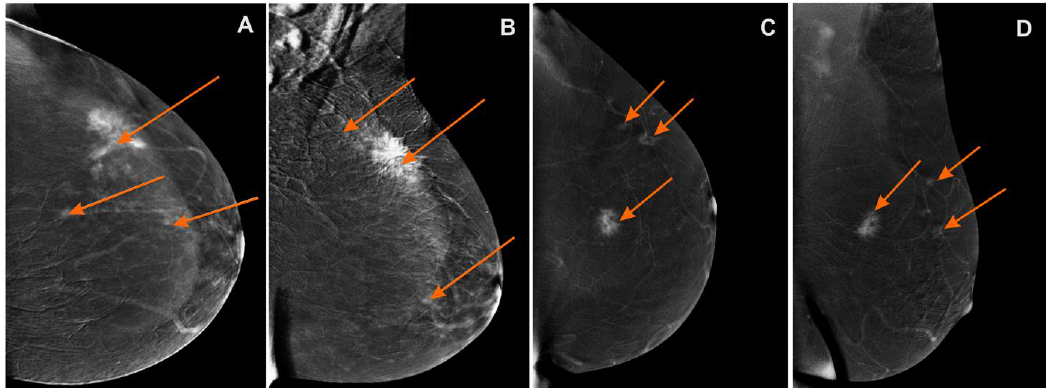
Figure 3. Contrast-enhanced spectral mammography (CESM)subtraction images: ( A ) craniocaudal ( CC ) and ( B ) mediola- teral oblique (MLO) views — irregular mass with heterogeneous enhancement and long spiculated mass BI-RADS 6. Nu- merous enhanced small foci are noted in left breast BI-RADS 4 (orange arrows); ( C ) craniocaudal (CC) and ( D ) mediola- teral oblique (MLO) views — irregular mass with heterogeneous enhancement and long spiculated mass BI-RADS 6. Ad- ditional enhanced small foci are noted in the left breast in superior-outer quadrant BI-RADS 4 (orange arrows).